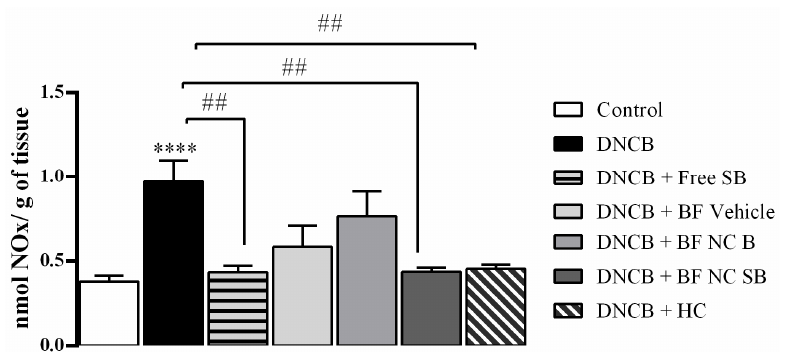
Figure 8. Effect of the different treatments on the NOx levels in the dorsal skin of mice exposed to DNCB. Each column represents the mean ± SEM of 7 mice per group. (****) p < 0.0001 compared with the control group and (##) p <0.01 compared with the DNCB group (One-way ANOVA followed by the Tukey’s test).